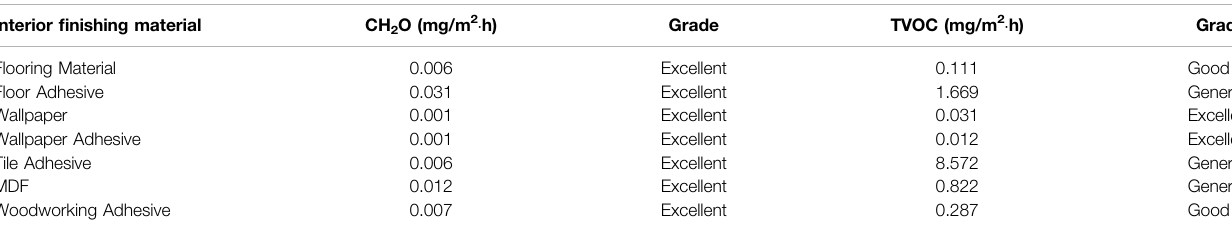
TABLE 7 | Indoor air pollutants from fi nishing material in two bedroom. Interior fi nishing material Flooring Material